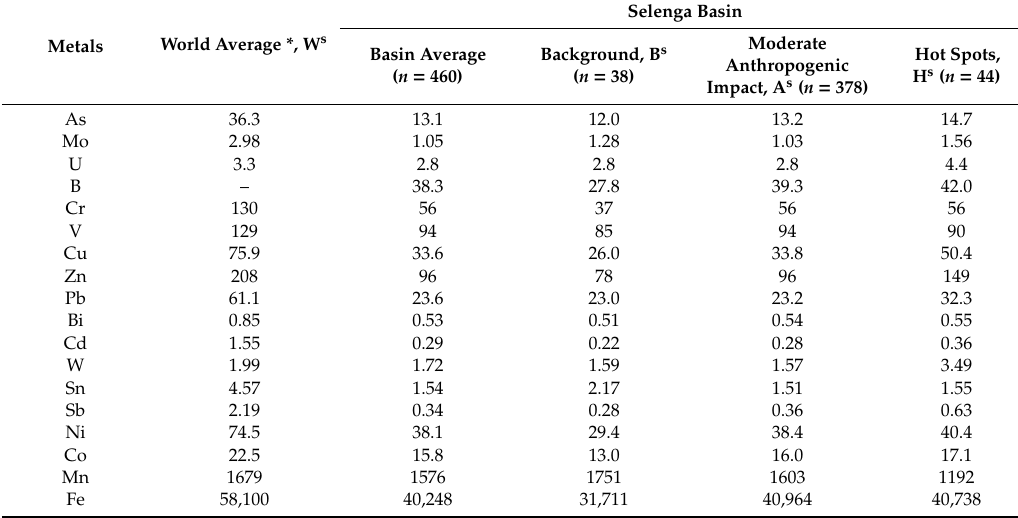
Table 3. Metals content in suspended sediments of the world and the Selenga River basin (mg · kg − 1 ): background and hot spots areas, and areas with moderate anthropogenic impact (median